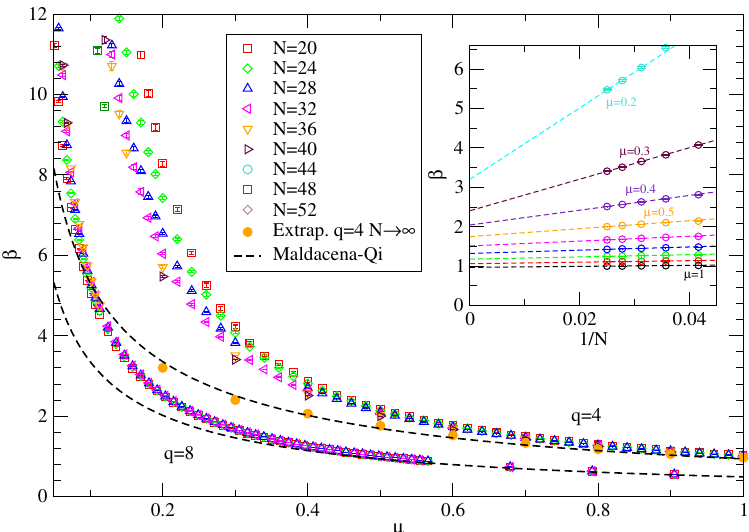
Figure 2 . Effective inverse temperature as a function of µ : comparison between the finite- N data for q = 4 and q = 8 and the analytical expression from [10]. The inset shows the 1 /N extrapolation for selected values of µ ( µ = 0 . 2 , 0 . 3 , . . . , 1 from top to bottom): the dotted lines are linear fits over the last three points ( N = 32 , 36 , 40